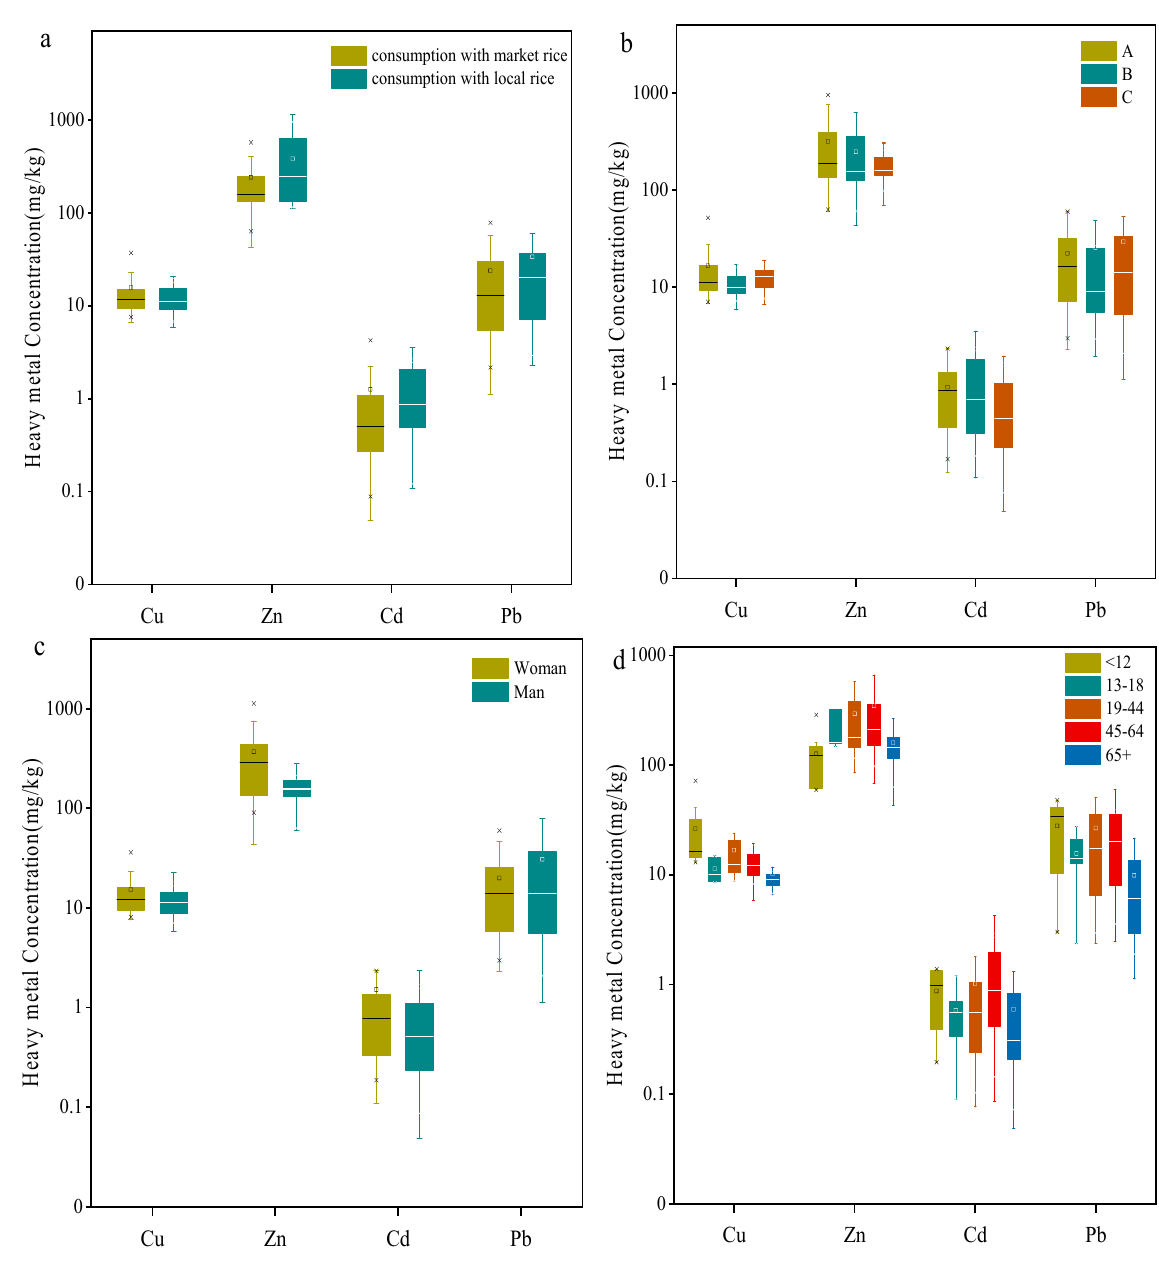
Figure 4. Heavy metal concentrations in human hair of as a function of ( a ) rice sources; ( b ) distance to smelter (A, B, C represented three sampling sites); ( c ) genders and ( d ) age. Middle band, box and whiskers represent the median, 25th and 75th percentile and 5th and 95th percentile, respectively. Squares represent means, whereas “*” represent extreme values.